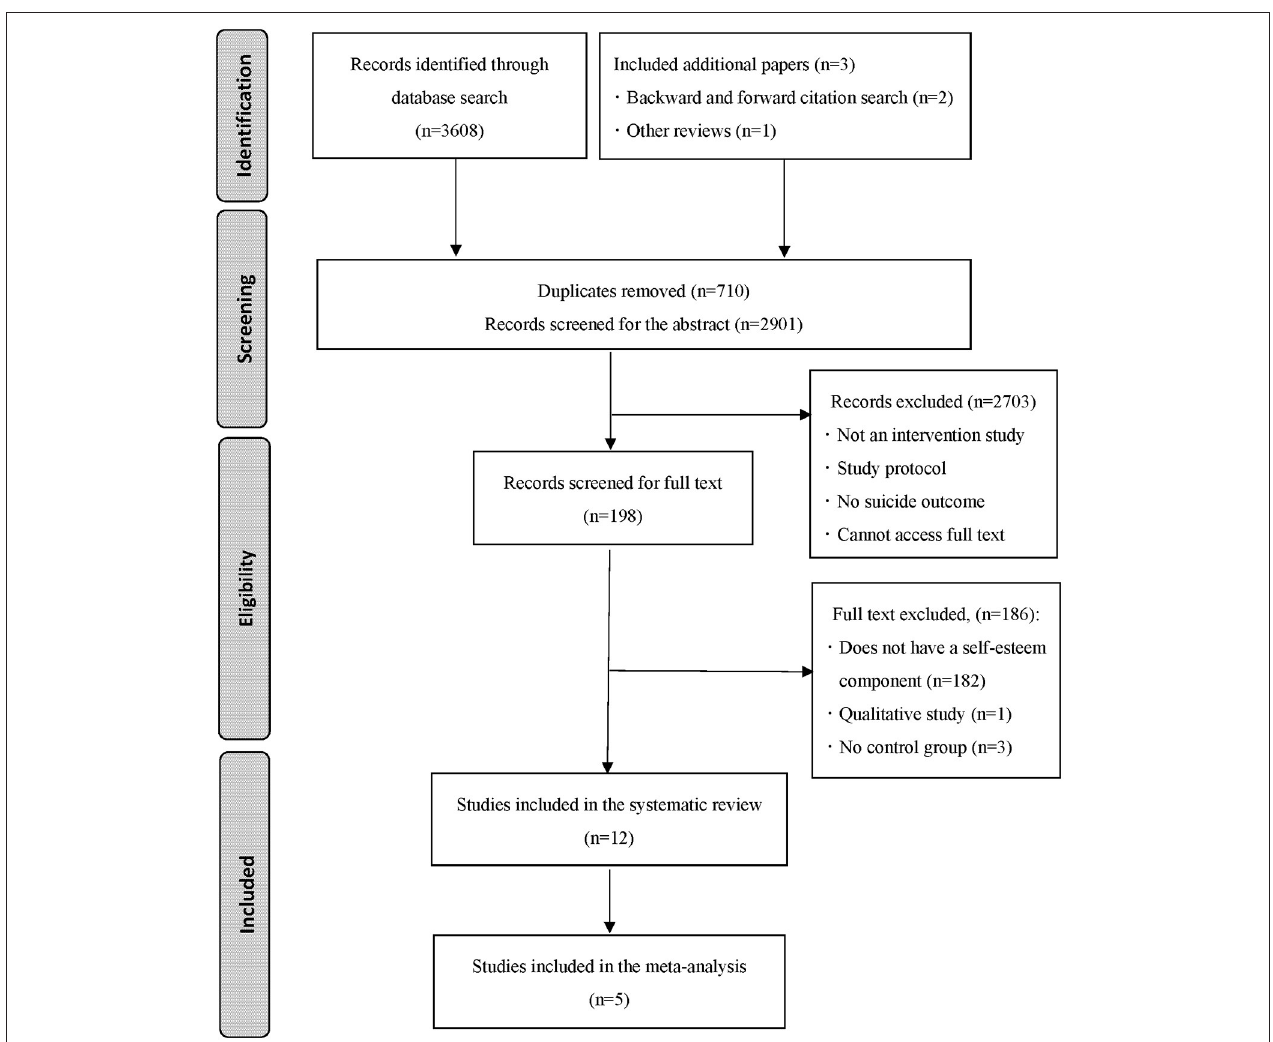
FIGURE 1 | PRISMA flowchart for the process of study